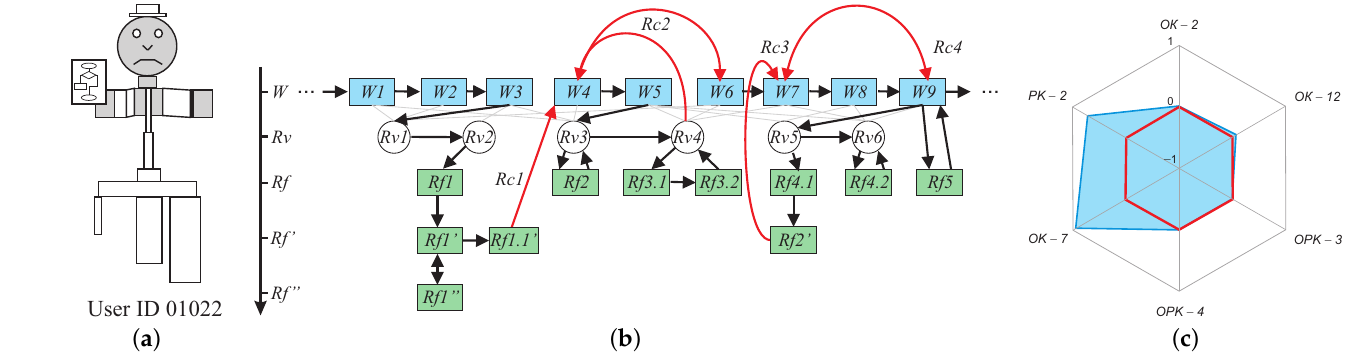
Figure 9. An individualized image of a student without data about their learning activity ( a ), the fragment of the student’s activity graph mined from the learning-system data ( b ), and their curricular competence profile ( c ) according to the results of middle-semester exams.